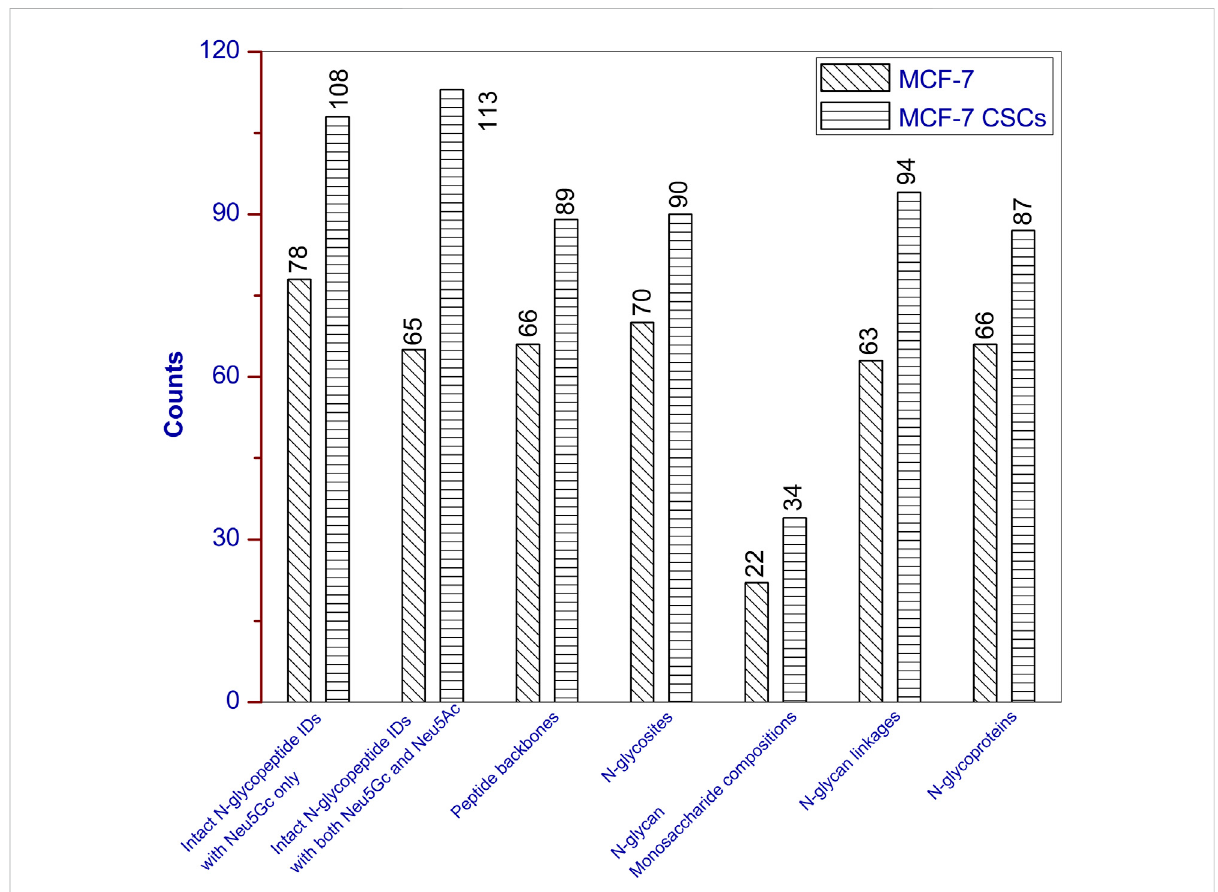
FIGURE 1 Unique intact N-glycopeptides with Neu5Gc and corresponding unique peptides, N-glycosites, N-glycan monosaccharide compositions, N-glycan linkages, and N-glycoproteins identi fi ed from MCF-7 and MCF-7